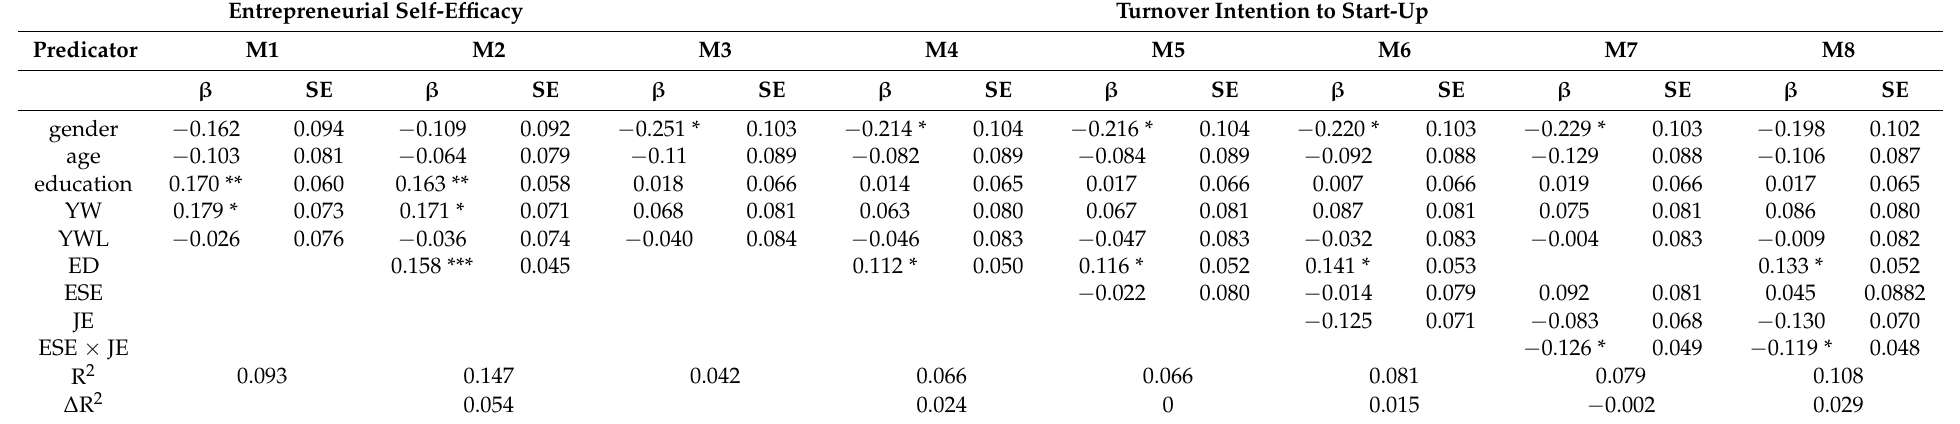
Table 3. Hierarchical